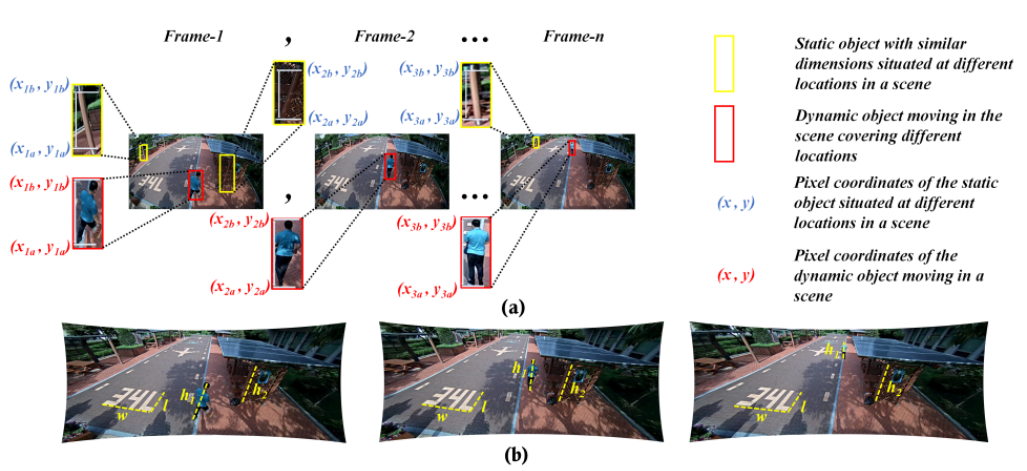
Figure 9. Retrieval of distortion-rectified reference pixel correspondences for better accuracy: ( a ) Top and bottom reference points in distorted case; ( b ) Corresponding top and bottom rectified reference points in rectified case.